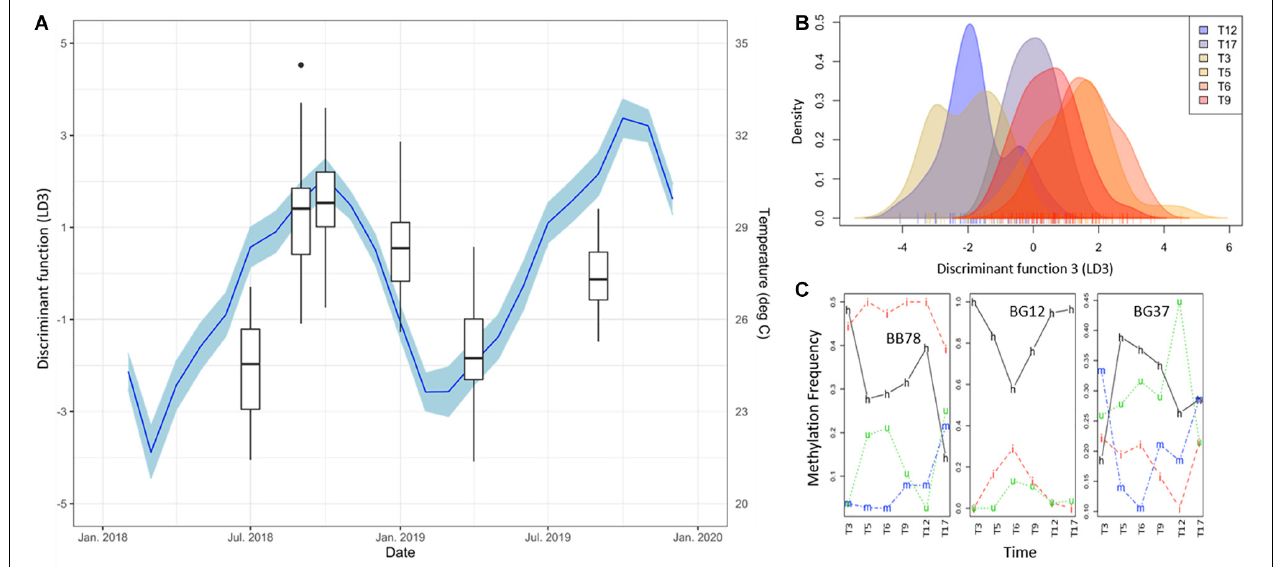
FIGURE 4 | (A) Time series of DNA methylation pattern separation as given by the DAPC discriminant function 3 (LD3, Box Plots). Black dots indicate outliers. Monthly average of daily mean temperature (NOAA Buoy CLBP4, blue line), lagg corrected + 1 as calculated with the ccf function in R, is shown as additional y -axes. Blue shadings indicate 95% confidence intervals of temperature variability. Note the clear seasonal variation of the DNA methylation patterns evidenced by this discriminant function and its significant correlation with temperature changes (Pearson’s rank correlation: r = 0.91, p = 0.0310). (B) Density of DNA methylation profiles of each A. cervicornis fragment against discriminant function 3 (LD3). (C) Temporal variation of the frequency of each methylation status of three loci with high contribution to LD3 (BB78, BG12, BG37). Methylation status is indicated in the lines of the figure: h, hemimethylated; m, hypermethylated; i, internal cytosine methylation; u, non-methylated